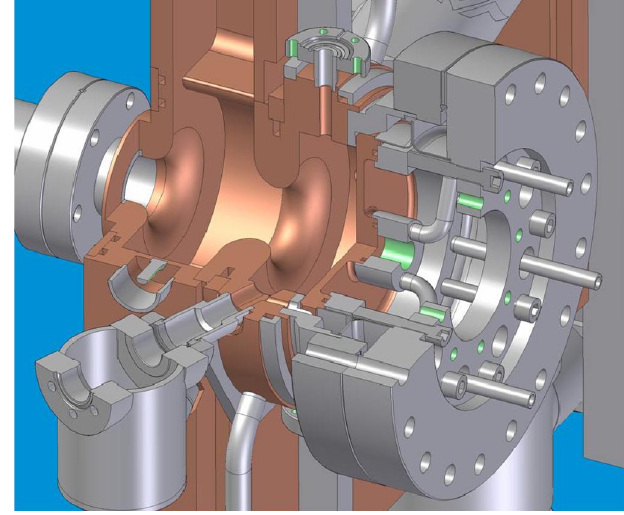
FIG. 5. (Color) The LCLS gun viewed from the cathode side with dual rf feed, cathode flange, and focusing solenoid.